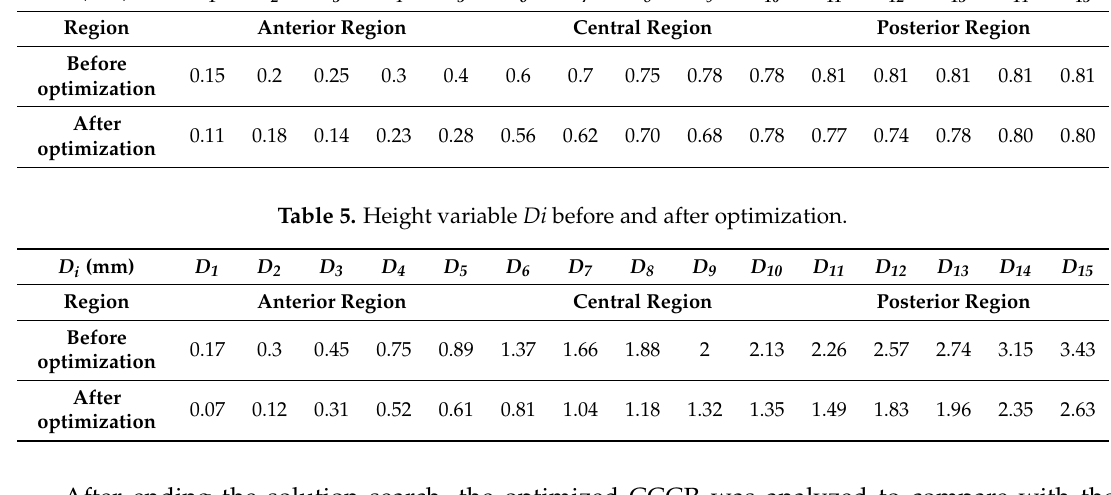
Figure 21. Flowchart of optimization process.